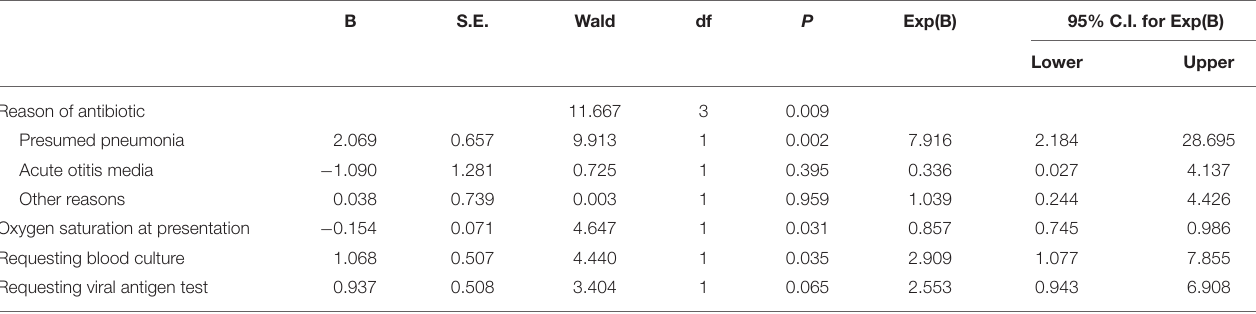
TABLE 2 | Multiple logistic regression of requesting chest radiograph (“yes”) vs. predictors listed in the footnote, using backward selection (likelihood ratio); P -value for the model is < 0.001. B S.E. Wald df P Exp(B)